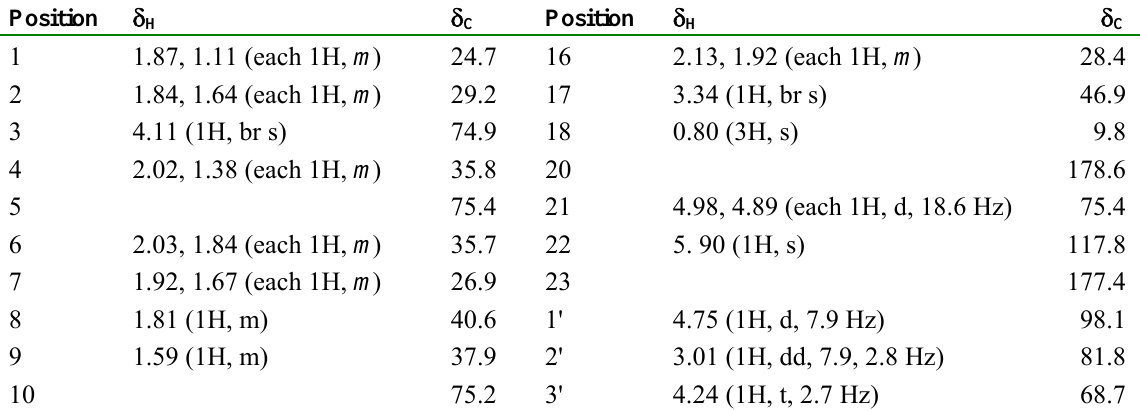
OD ( 1 H: 400 MHz; 13 C: 100 MHz;  in ppm, J in 3